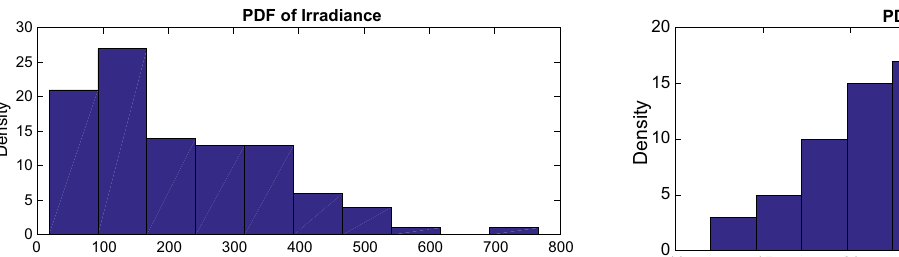
Fig. 8 Hybrid system load probability distribution